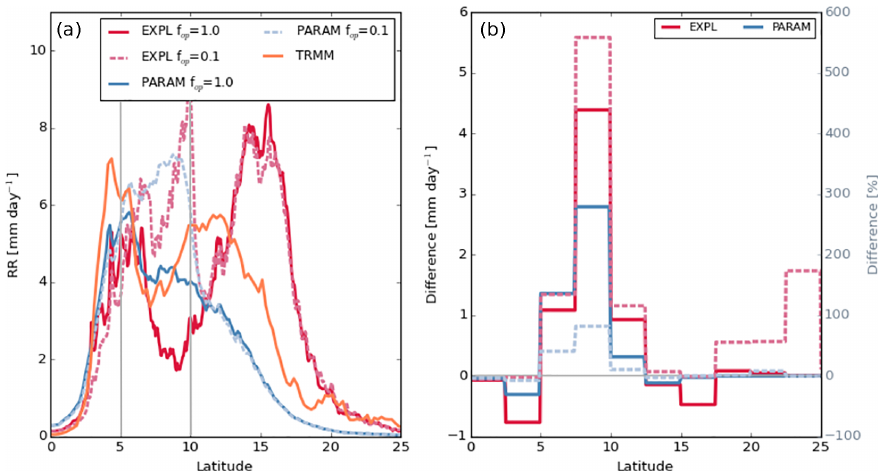
Figure 9. South–north distribution of 8 ◦ W–8 ◦ E averaged RR from various ICON simulations and TRMM observations (according to the legend) for July 2006: (a) absolute amounts and (b) differences f op = 0 . 1 minus f op = 1 . 0 as absolute (solid) and relative (dashed) values. For better visibility, the data points were binned every 2.5 ◦ latitude in (b)